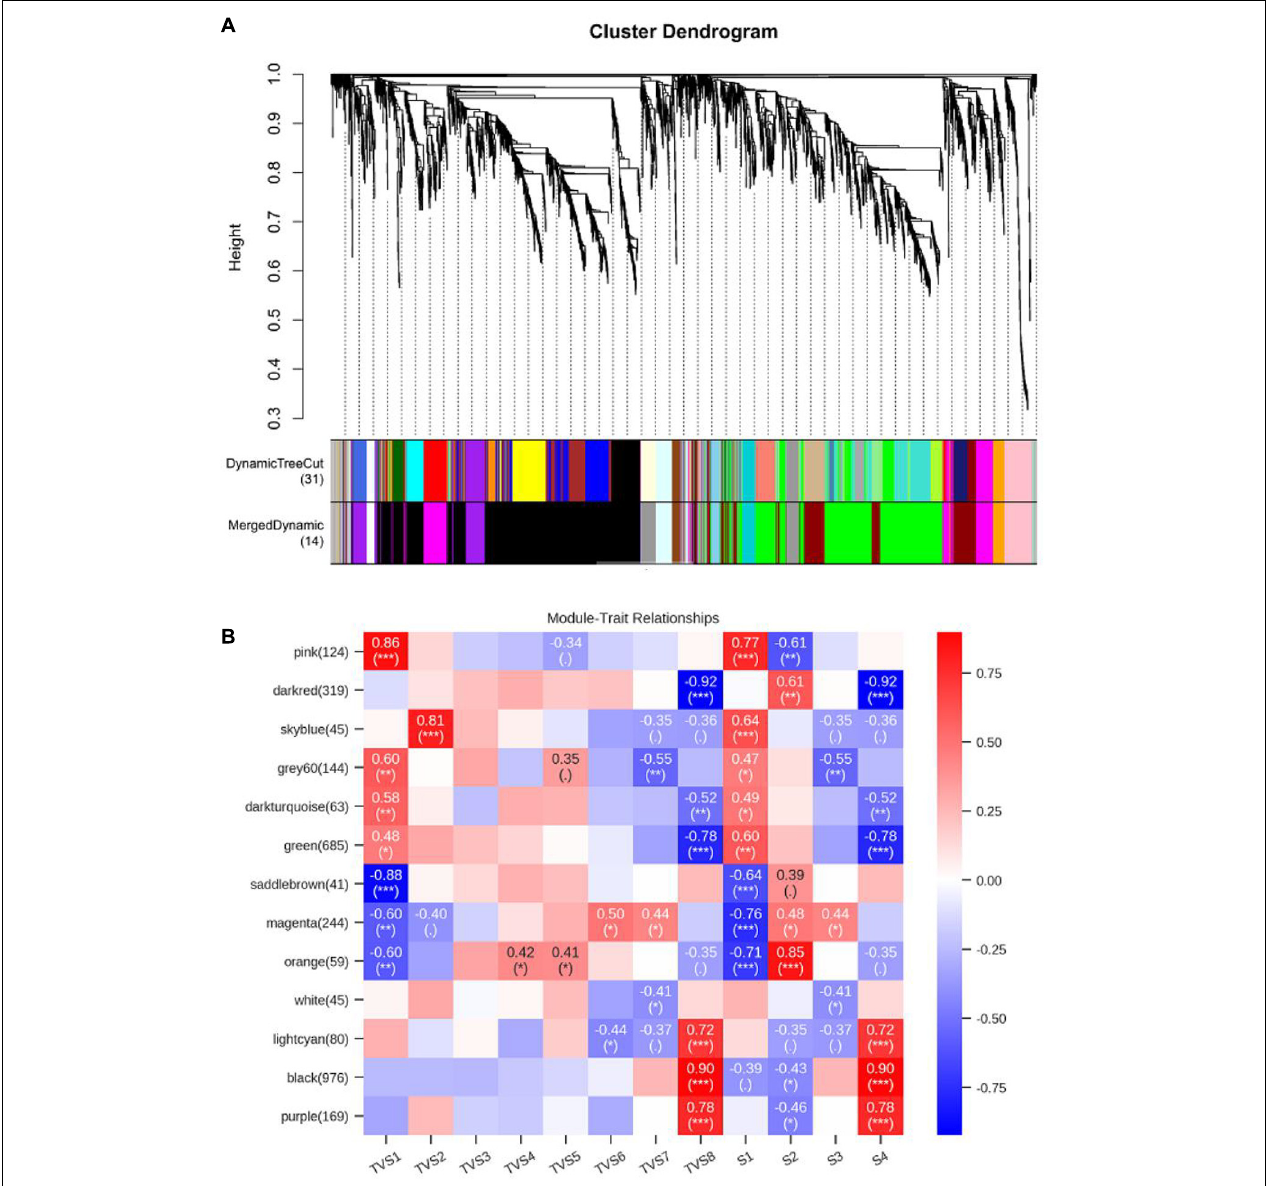
FIGURE 7 | Weighted gene co-expression network analysis (WGCNA) of genes in different CF stages of T. virens GV29-8. (A) Cluster dendrogram of genes based on expression levels during the 8 sampling time points and 4 developmental stages. Each branch represents a gene and each color below represents a gene co-expression module. The dynamic tree cut indicates the modules were divided based on the gene clustering results. The merged dynamic cut indicates the modules were divided by combining modules with similar expression patterns. (B) Heatmap of gene expression patterns during the 8 sampling time points and 4 developmental stages. The expression patterns of 13 modules are shown by the heatmap. Each column represents a developmental stage. The module name is shown to the left side of each cell. The number of genes in each module is indicated in parentheses. Numbers in the table report the correlations of the corresponding module genes and stages, with the p -values ( ∗ ) printed below the correlations in parentheses. Each column corresponds to a specific stage. The scale bar on the right indicates the range of possible correlations from positive (red) to negative